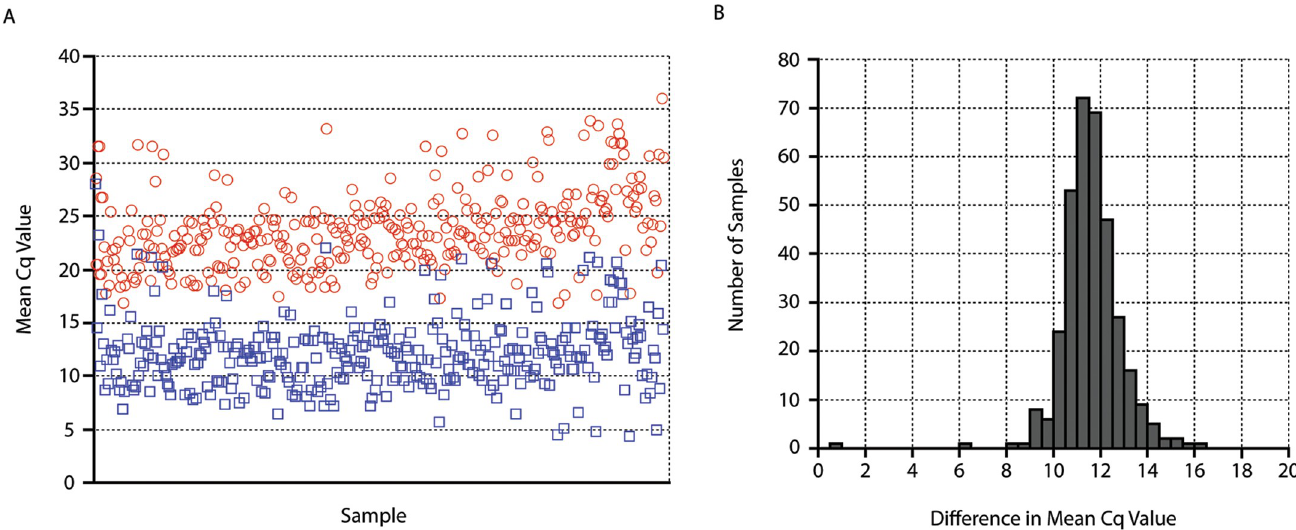
Fig 4. Differences between mean Cq values for all samples co-positive using both the ribosomal ITS-targeting assay and AGR qPCR assay. (A) For each co- positive sample, mean Cq values were plotted for both the ribosomal ITS-targeting assay (red circles) and the AGR assay (blue squares). (B) For each co-positive sample, a difference in mean Cq values was calculated by subtracting the mean value for the ribosomal ITS qPCR assay from the mean value for the AGR qPCR assay. Results were binned by difference and plotted. The average difference across all plotted samples was determined to be 11.51